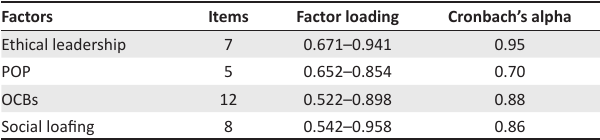
TABLE 2: Items retained and their item range.